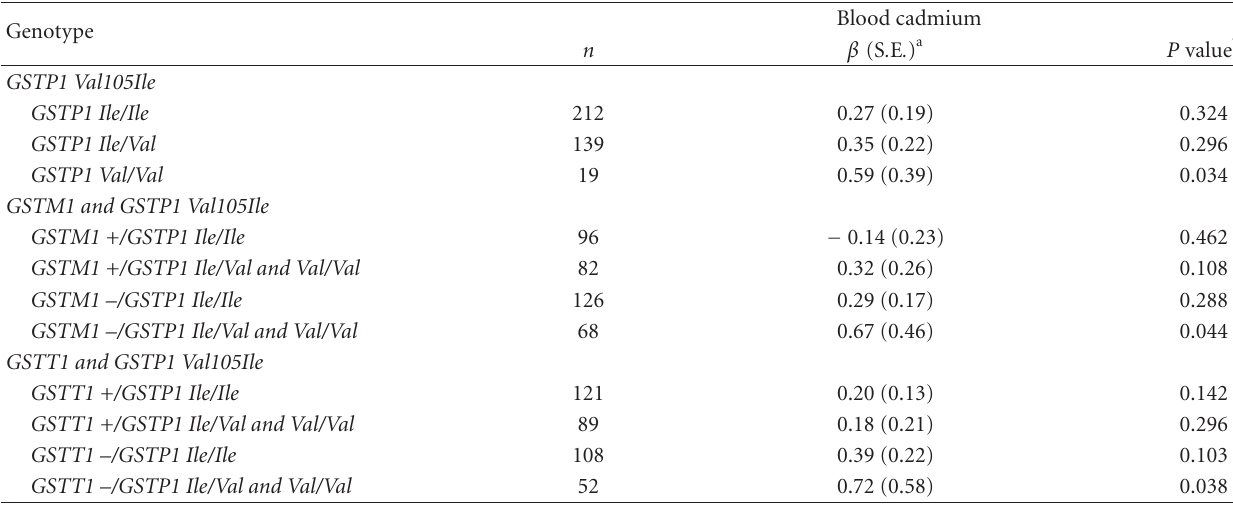
Table 3: Regression coe ffi cient for blood cadmium by GSTP1 Val105Ile and interaction between GSTP1 Val105Ile and GSTT1 and GSTM1.